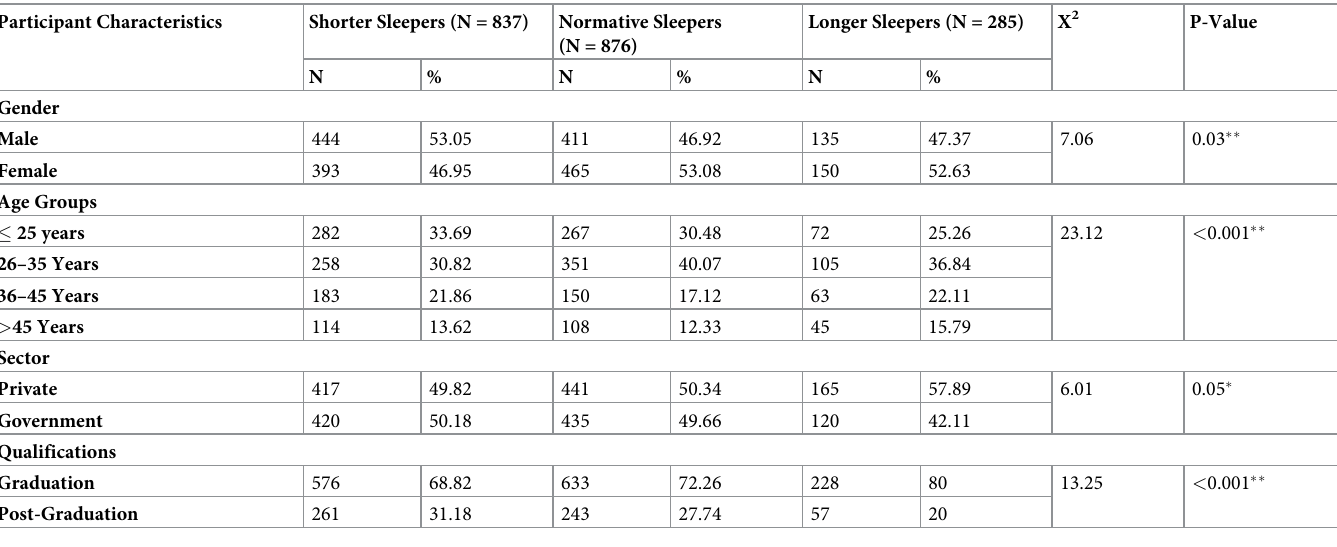
Table 2. Sleep durations of respondents.